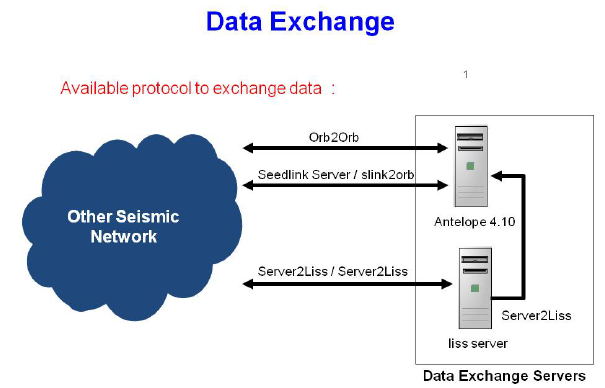
Fig. 8. Data exchange with other Data